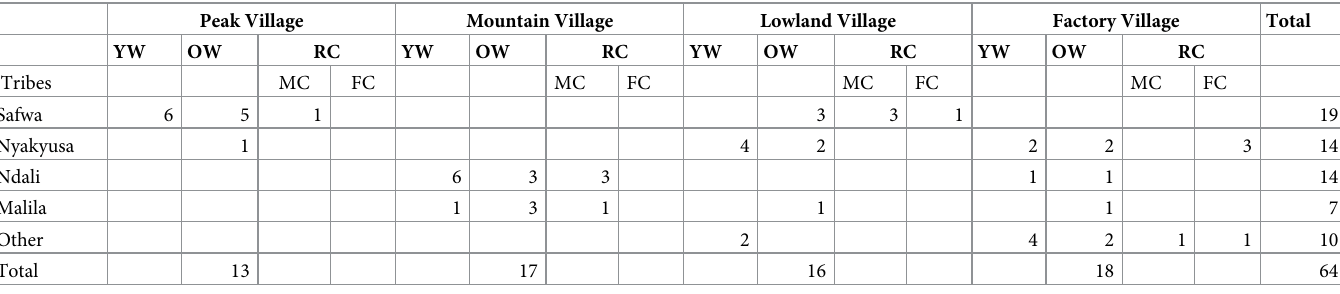
Table 1. Characteristics and tribal ethnicity of 64 informants from the four study villages. Peak